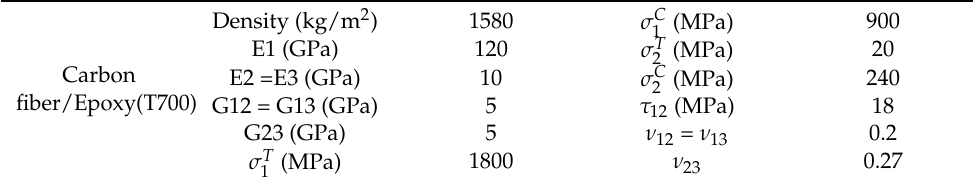
Table 4. Mechanical properties of carbon fiber reinforced composites.